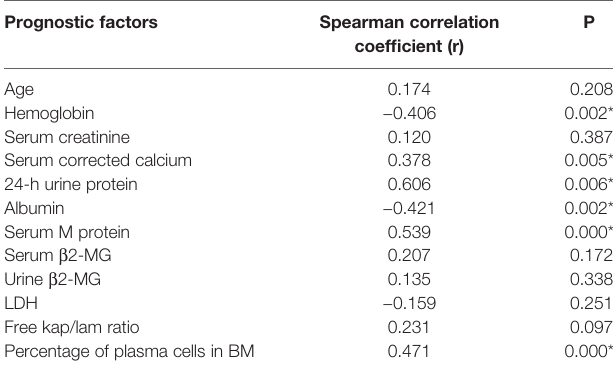
P coef fi cient (r)